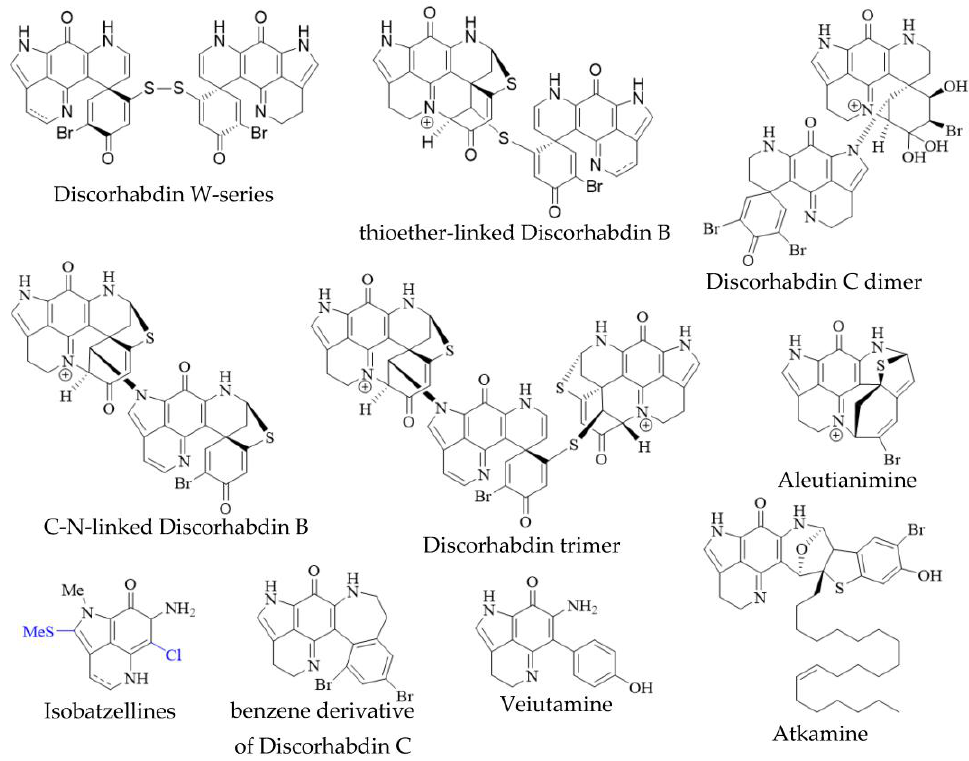
Figure 3. Unusual pyrroloiminoquinones from marine sponges. Variable substituents are shown in blue.